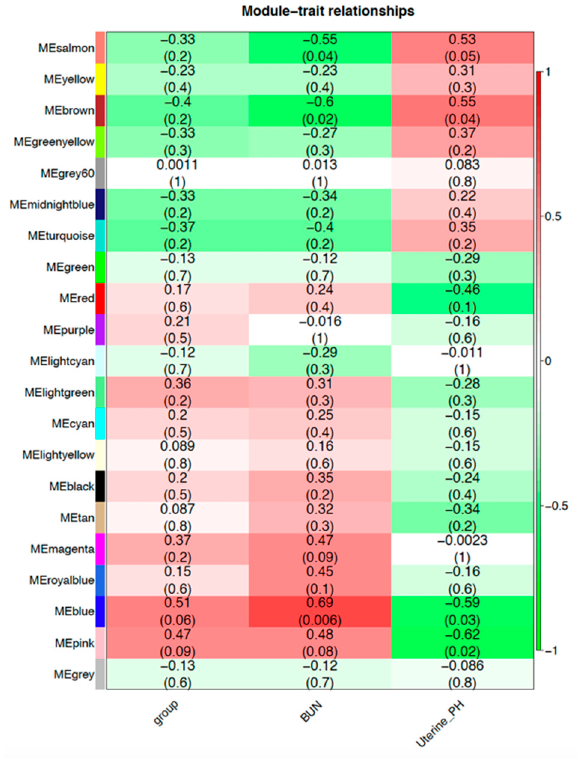
Figure 5. Gene expression modules with weighted correlation network analysis (WGCNA). Matrix with the module-trait relationships and corresponding p -values of the modules on the y-axis and selected traits related with treatment on the x-axis. The y-axis is colored according to the correlation, with red representing a strong positive correlation and green representing a strong negative correlation. Traits are: Group (control and urea groups), BUN (blood urea nitrogen concentrations at hour 6 of treatment), and uterine pH (uterine pH measured at hour 6 of treatment).